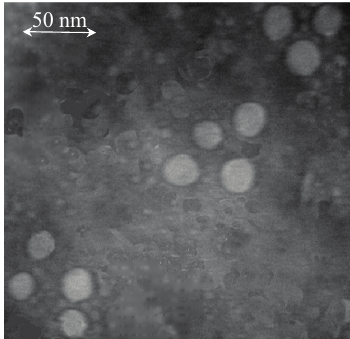
Figure 5. Examination of hybrid HBcAg VLP protein by transmission electron microscopy.